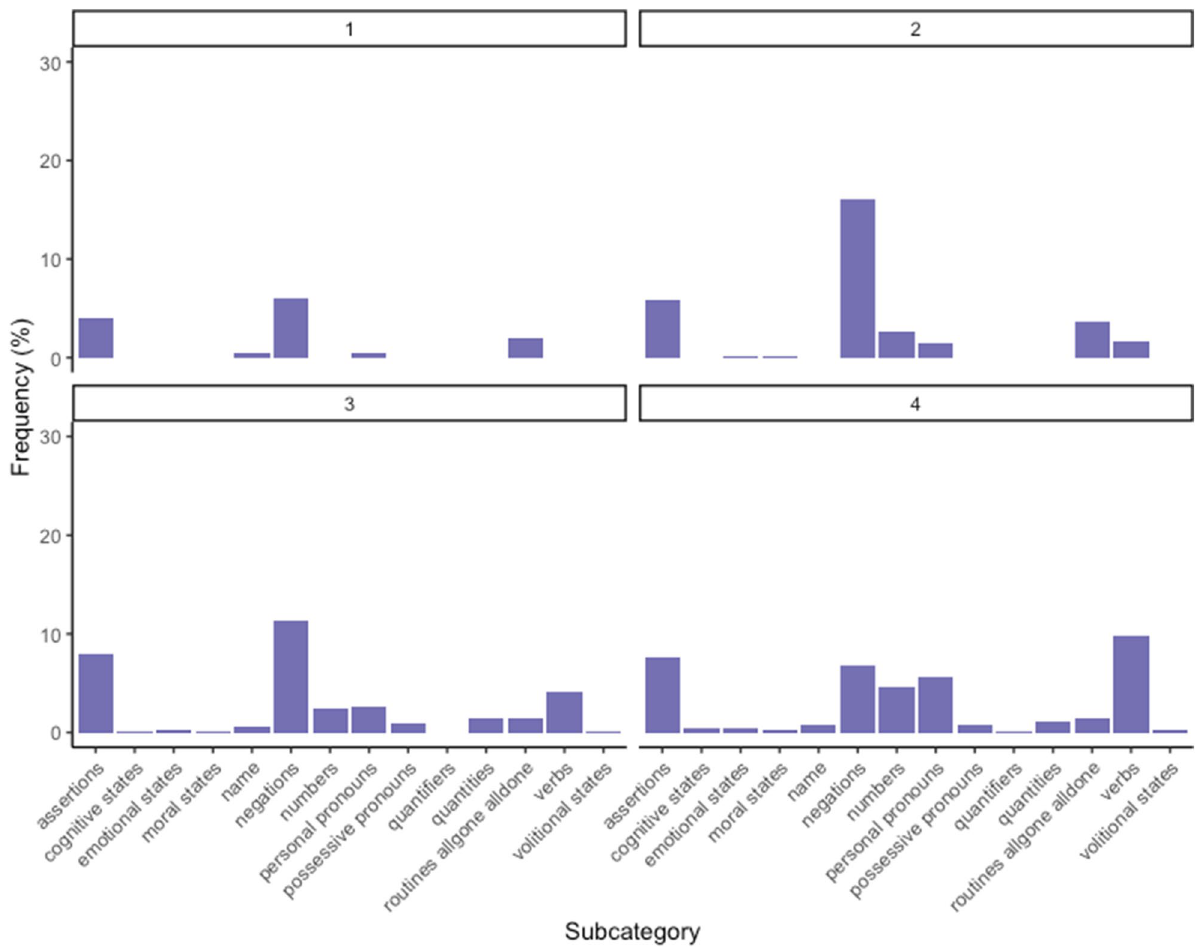
Figure 4. Percentage of words produced by children of age group 1 (12–15 months), age group 2 (16– 18 months), age group 3 (19–21 months) and age group 4 (22–24 months) for subcategories with high level of